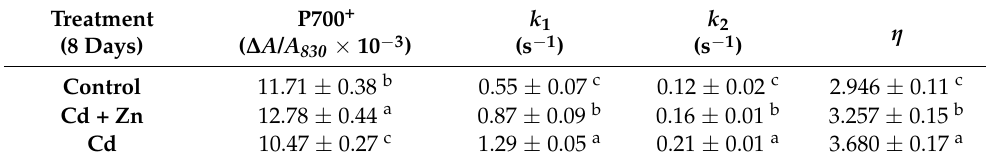
the chlorophyll fluorescence parameters, followed by post-hoc analysis with Games–Howell test. Table 3. Effects of the excess (900 µ M) Zn on the Cd-induced changes in the relative membrane microviscosity ( η ) and the PSI photo-oxidation (P700 + ) measured by relative amplitudes of FR-light induced absorbance changes (expressed as ∆ A / A 830 × 10 − 3 ) and the rate constants of P700 + dark reduction ( k 1 and k 2 ) in leaves of Salvia sclarea